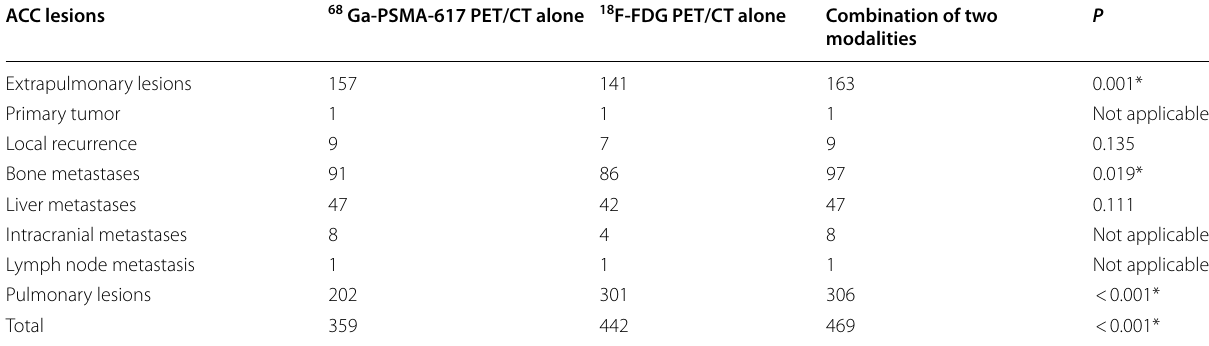
Table 3 Number of PET-positive lesions detected by 68 Ga-PSMA-617 PET/CT and 18 F-FDG PET/CT ACC lesions